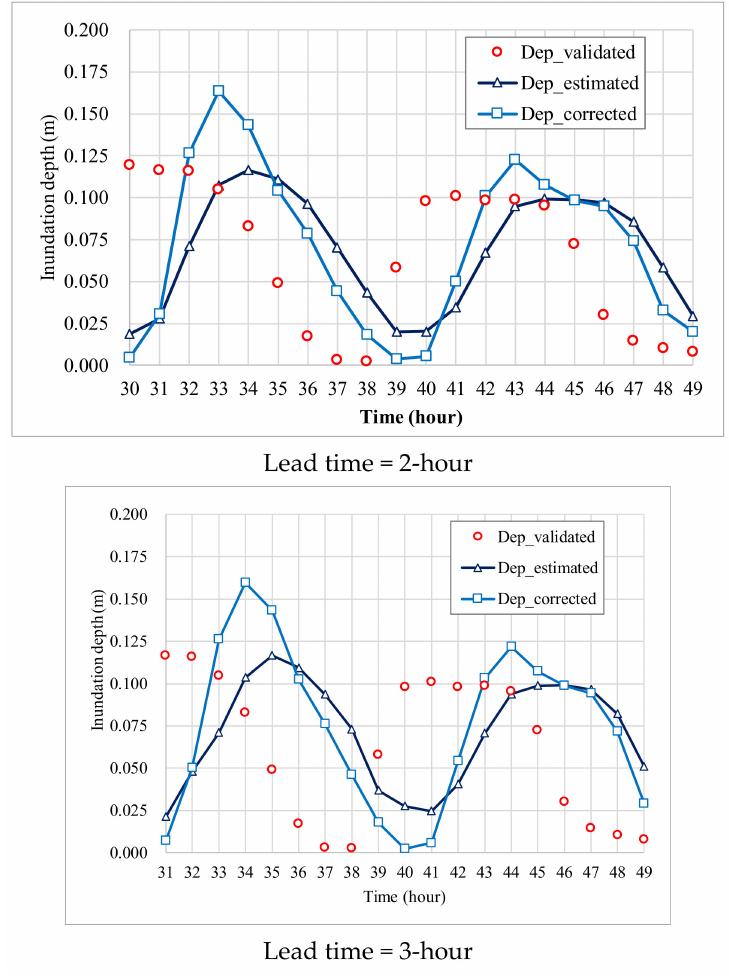
Figure 16. Comparison among the validated inundation depths and the corrected as well as corrected ones by the proposed SM_EID_IOT model during the validated rainfall-induced flood event.